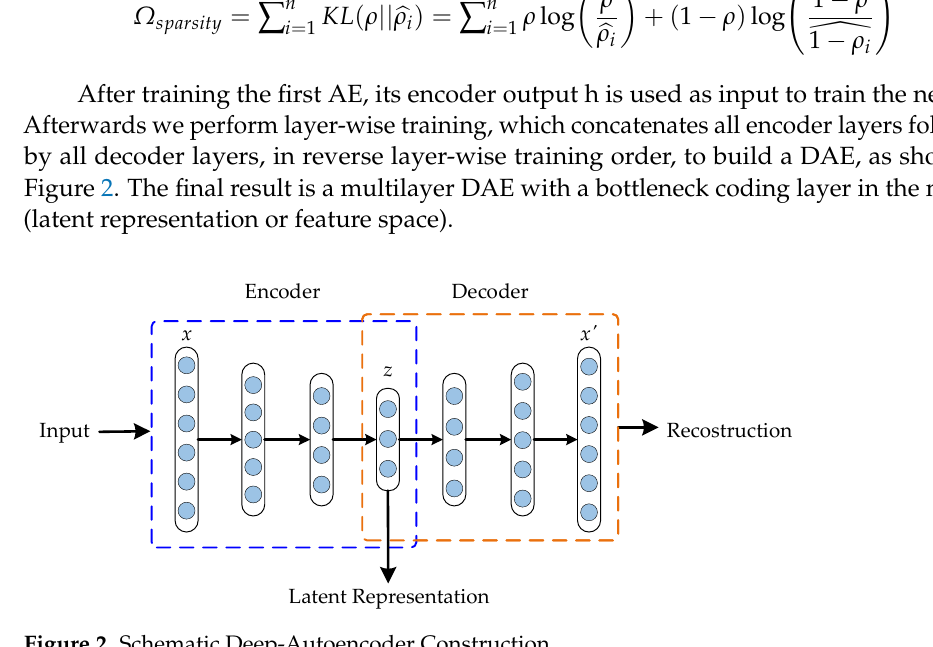
Figure 2. Schematic Deep-Autoencoder